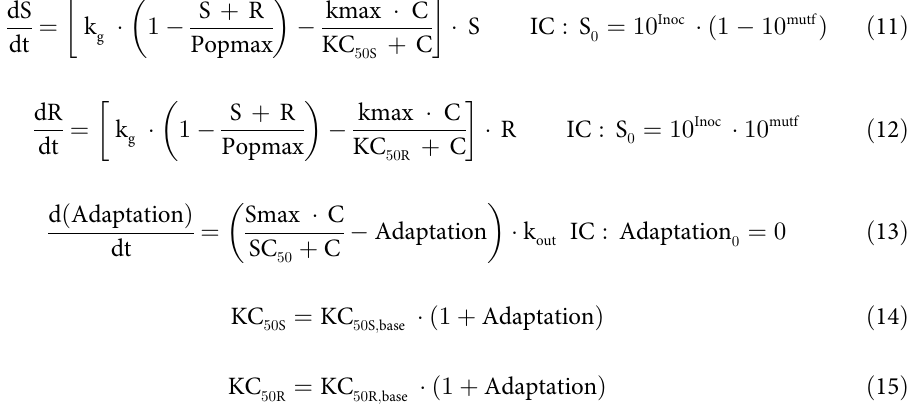
Table 1. Parameter values used for Monte Carlo simulations Descriptions Parameters Units Used in